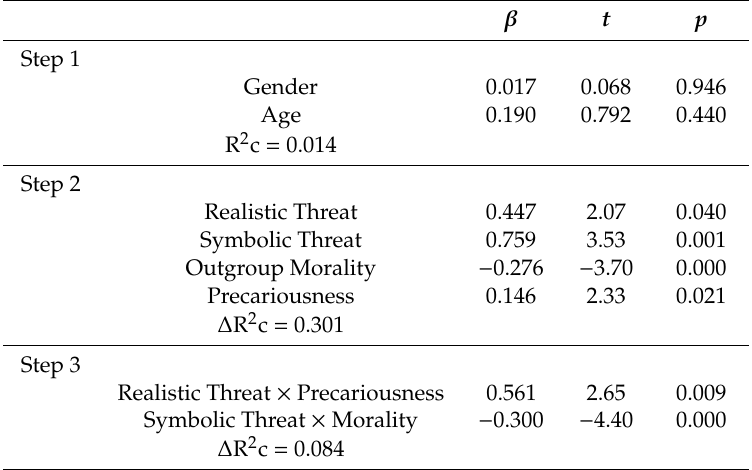
Table 1. Multiple regression analysis on prejudice.